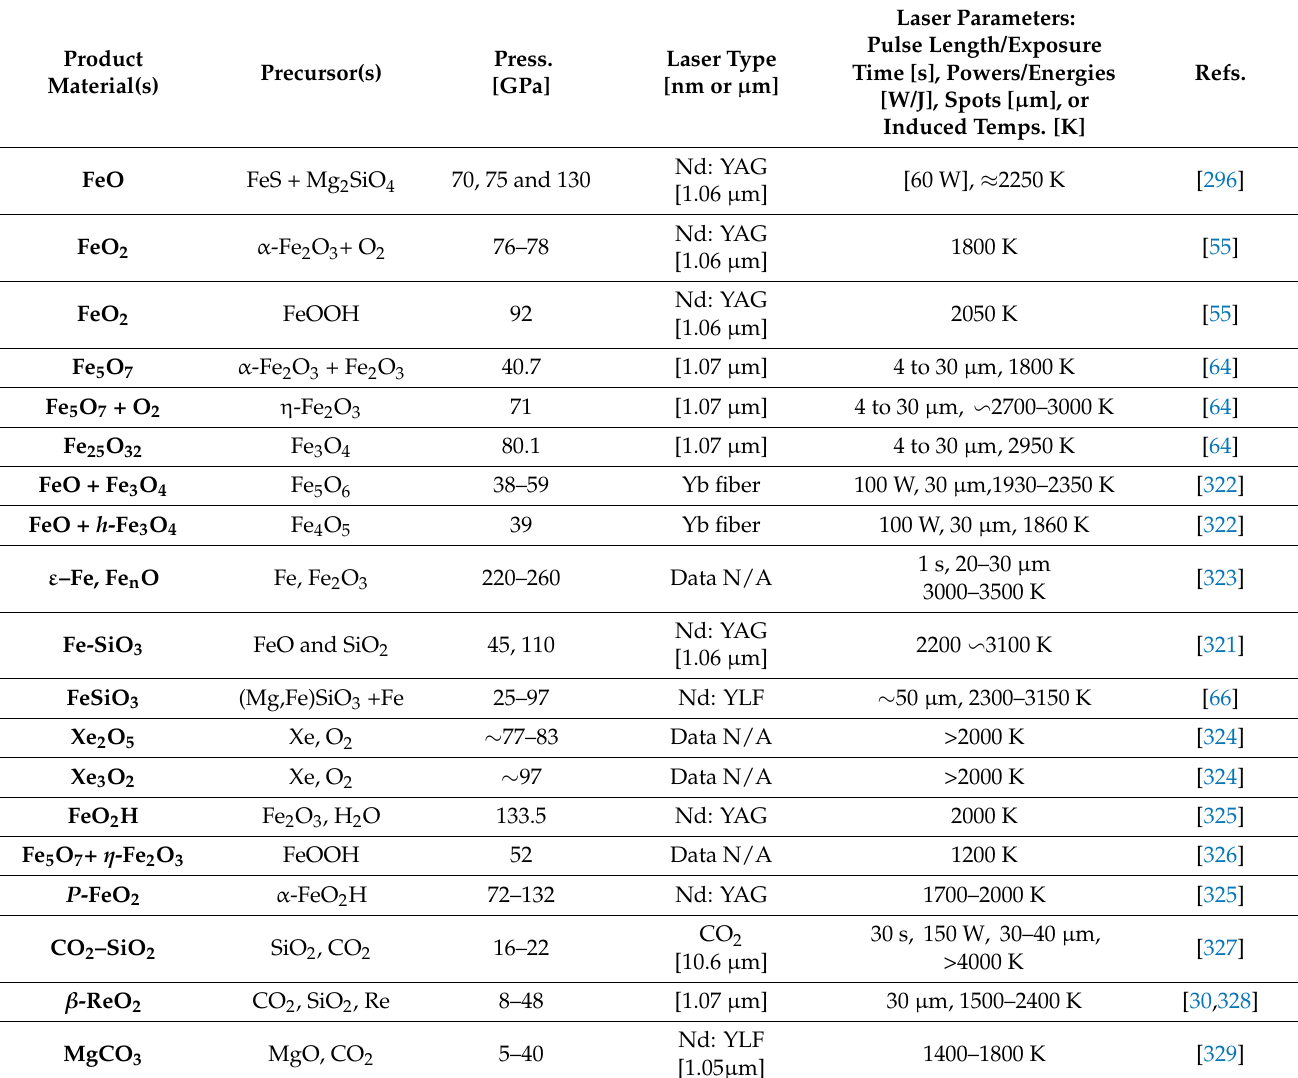
Table 9. Binary Metal Oxides: Metal Oxides Synthesised During Selected LRS-DAC